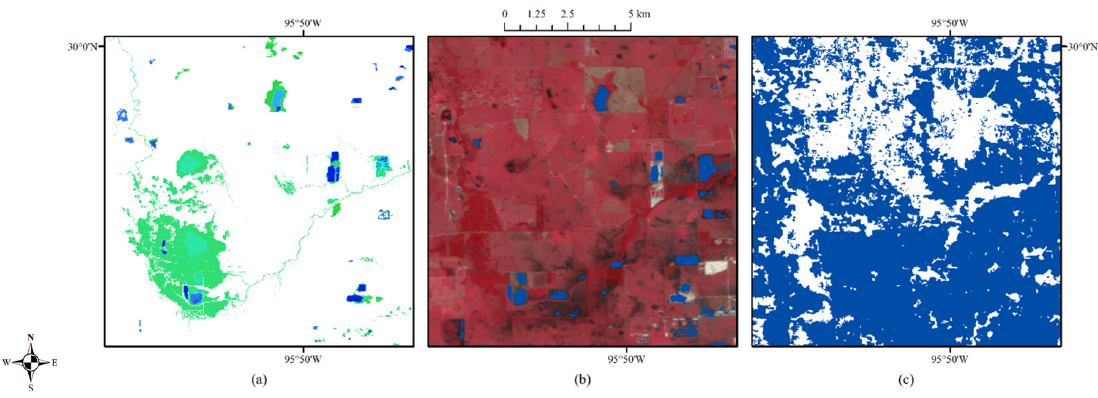
Figure 11. Enlarged site (A): inundation probability ( a ), the corresponding optical image on September 1 ( b ), and ( c ) FEMA flood map, with water shown in blue.